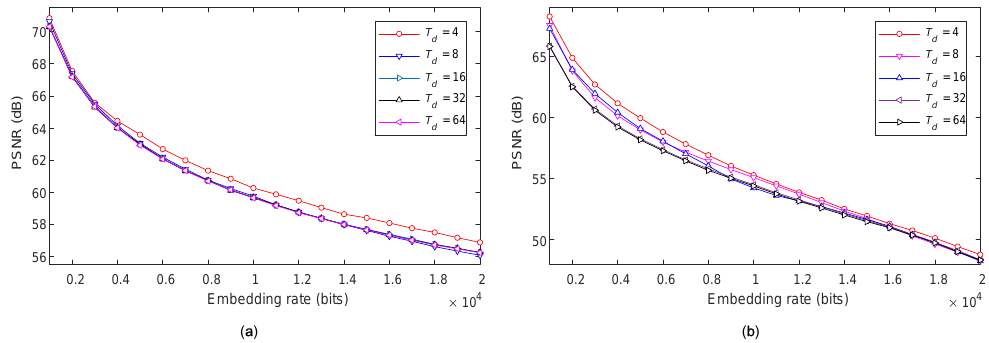
Figure 8. The payload-distortion performance due to large T d for the images Lena and Baboon : ( a ) Lena , ( b ) Baboon